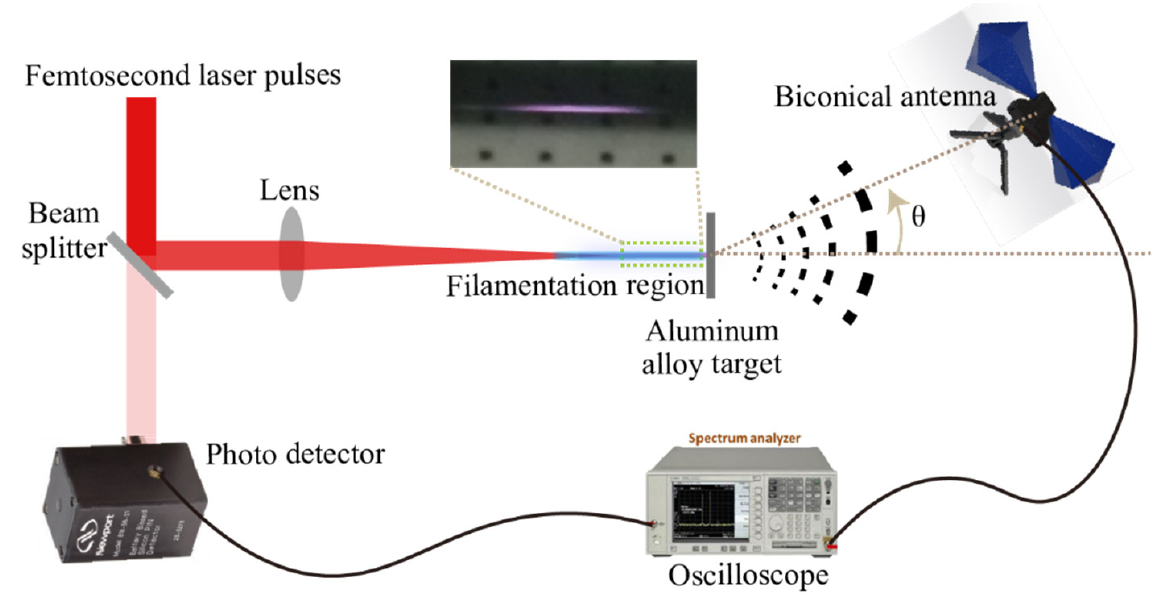
Figure 1. Schematic diagram of the femtosecond laser filament interacting with a solid target.